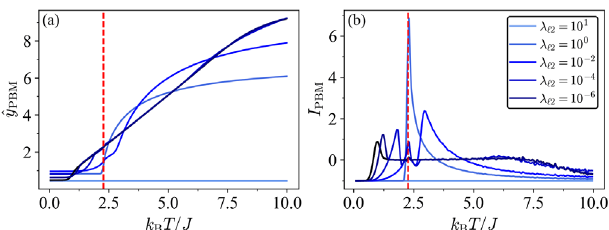
( L ¼ 14 ) using an NN composed of a single hidden layer with 128 nodes for various numbers of training samples M parameter value, where M sponding optimal loss based on the training or validation dataset is highlighted by a colored dashed line. The optimal loss based on the ground-truth probability distributions is highlighted in black.